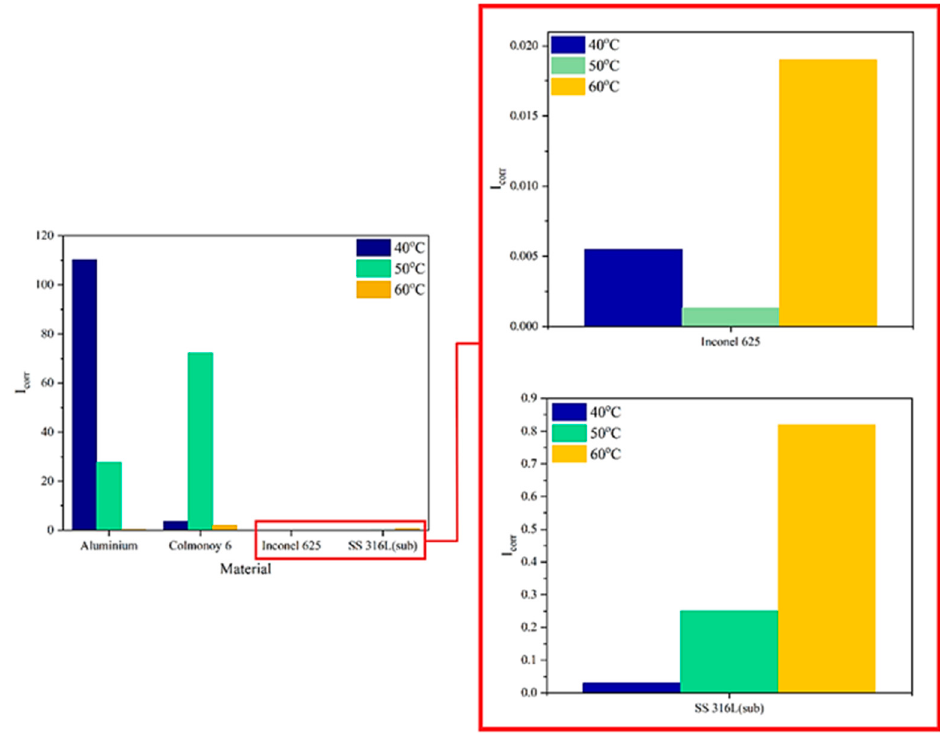
Figure 8. Potential of different coating samples at different temperatures.